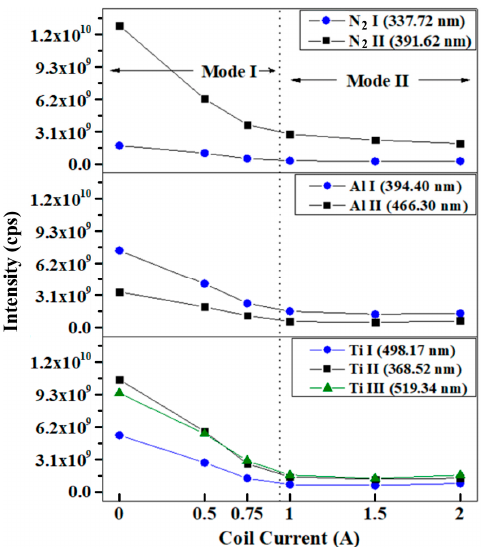
Figure 6. Intensities of detected optical emission lines of neutral Ti (498.17 nm), singly ionized Ti + (368.52 nm), doubly ionized Ti ++ (519.34 nm), neutral Al (394.40 nm), singly ionized Al + (466.30 nm), neutral N 2 (337.72 nm), and singly ionized N 2+ (391.62 nm), as a function of coil current.